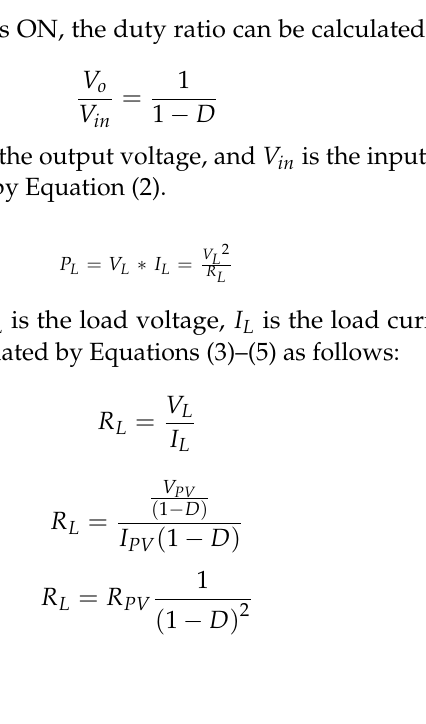
Figure 4. ( a ) ON-mode condition; ( b ) OFF-mode condition.